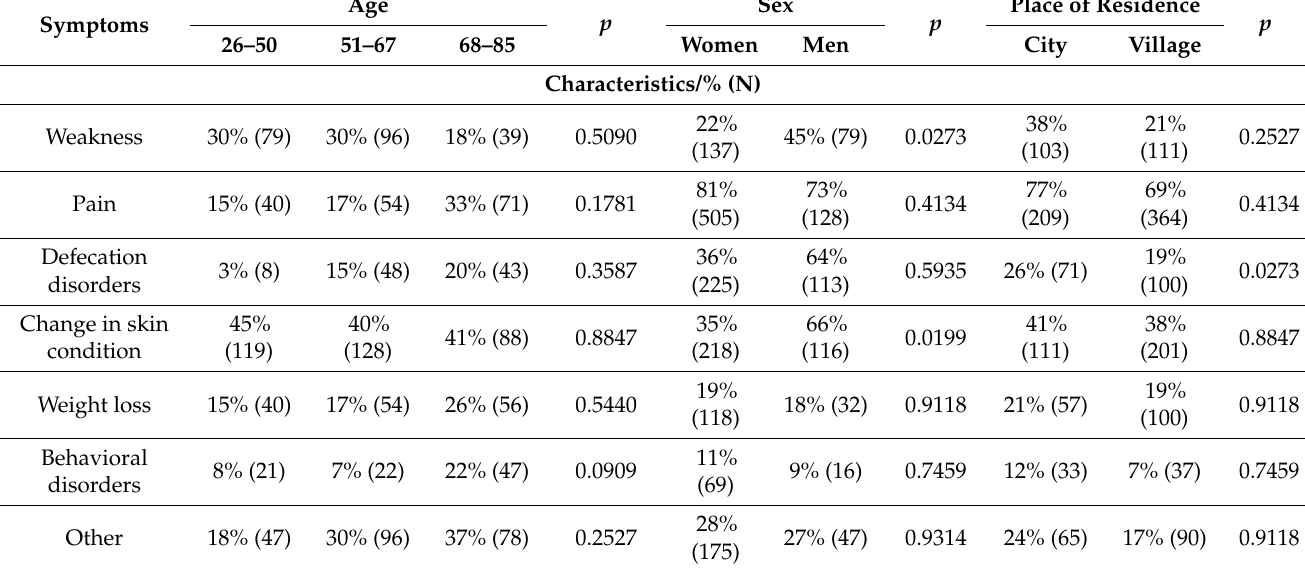
Table 3. Type of symptoms experienced among